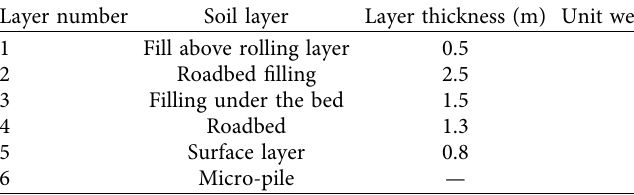
Table 2: Physical and mechanical parameters of the subgrade fill material.